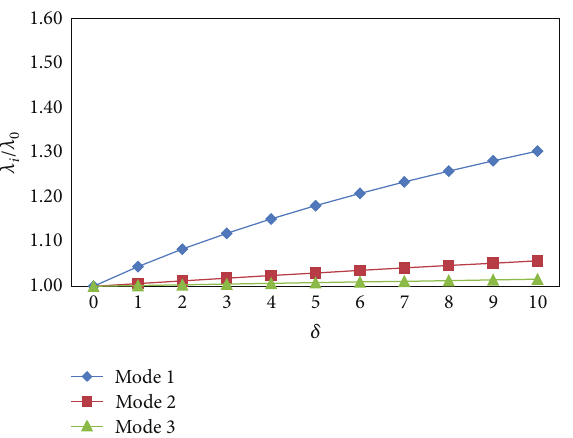
Figure 3: Effect of elastic foundation parameter on the vibration frequencies for 𝑆 0 = 10 5 , 𝑆 𝐿 = 10 5 , Ω 0 = 10 5 , and Ω 𝐿 = 10 5 .